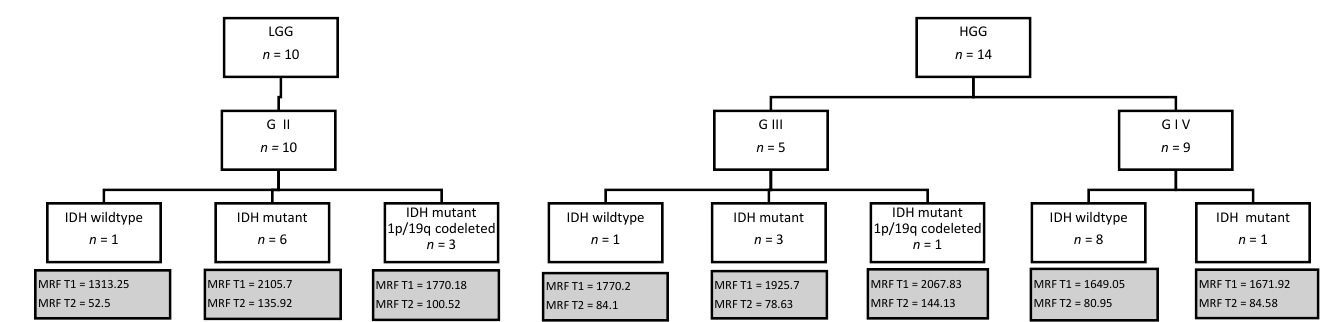
Figure 5. Mean of MRF T1 and T2 relaxation time values in the solid part of the tumor in IDH- wildtype, IDH-mutant, and IDH-mutant and 1p/19q codeleted diffuse gliomas, according to their tumor grade. Within our cohort of ten LGGs, one was an IDH-wildtype and six were IDH-mutants. Within the group of 14 HGGs nine were grade IV, and five were grade III gliomas. The cohort of the nine grade IV gliomas consisted of eight IDH-wildtype and one IDH-mutant gliomas. Due to the low sample size, only a descriptive analysis could be done. Please note lower means of MRF T1 and T2 relaxation time values within the one grade II IDH-wildtype glioma than within the six grade II IDH-mutant gliomas (non-codeleted), and the grade IV IDH-wildtype gliomas. Furthermore, a minimally higher mean of MRF T1 and T2 relaxation time values was observed within the one grade IV IDH-mutant glioma compared to the eight grade IV IDH-wildtype gliomas.